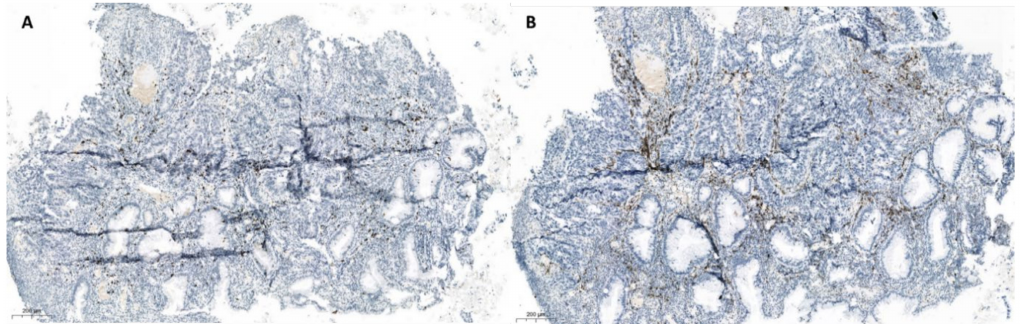
Figure 3. Histologic presentation of a small biopsy of a colon carcinoma with similar amount of CD8 ( A ) and CD4 ( B ) positive lymphocytes.